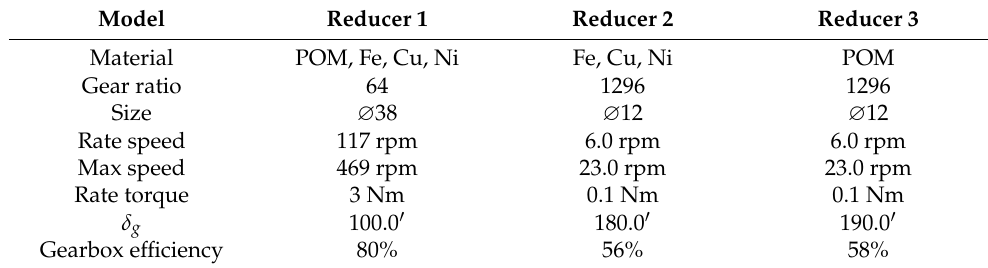
Figure 8. Composition of reducer 1. Table 1. The parameters of small-size reducer.